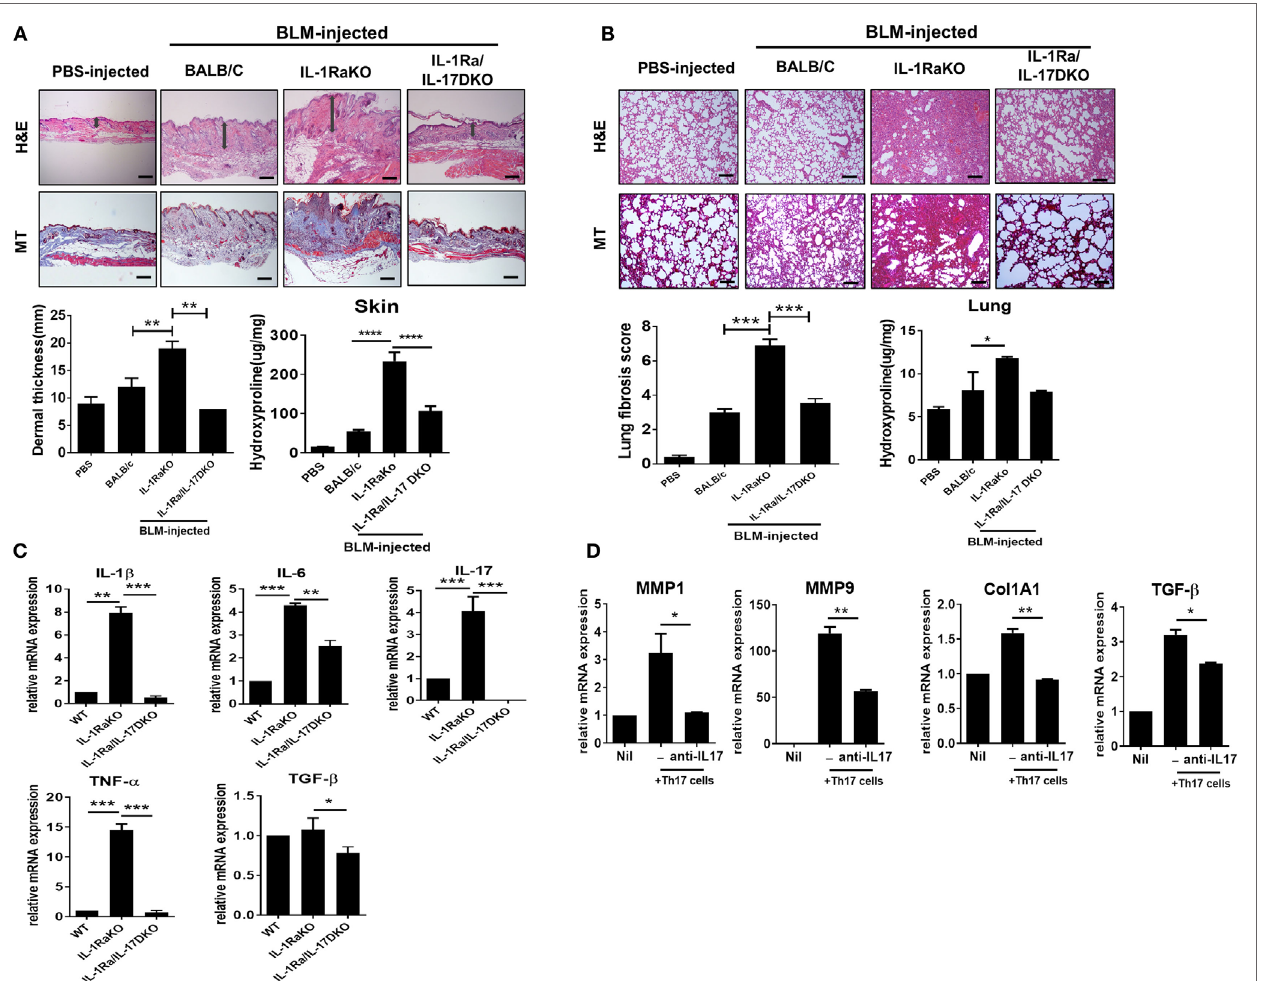
FigUre 2 | Augmented fibrosis in skin and lung tissue from IL-1 receptor antagonist-deficient (IL-1Ra-KO) mice depends on IL-17 activity. Wild-type (WT) BALB/c mice mice received daily injections of phosphate-buffered saline or bleomycin (BLM) for 28 days ( n = 6/group). IL-1Ra-KO and IL-1Ra–IL-17-double KO (DKO) mice received daily injections of BLM for 28 days ( n = 6/group). Then, skin and lung samples were isolated and analyzed. (a,B) Left panel, representative sections stained with hematoxylin and eosin, and Masson’s trichrome (MT) in skin (a) and lung (B) . Original magnification 100 × . Scale bar represents 200 µm. Right panel, quantification of dermal thickness in affected skin and pulmonary fibrosis, showing greater dermal thickness and lung fibrosis in IL-1Ra-KO mice injected with BLM relative to those in WT mice and a significant reduction in IL-1Ra–IL-17-DKO mice relative to those in IL-1Ra-KO mice. Hydroxyproline content in skin and lung tissues from each group of mice. Values are the mean ± SEM of six mice per group. (c) mRNA levels of IL-1 β , IL-6, IL-17, TNF- α , and TGF- β in skin samples from WT, IL-1Ra-KO, and IL-1Ra–IL- 17-DKO mice treated with BLM as determined by real-time quantitative polymerase chain reaction analysis. (D) mRNA levels of MMP1, MMP9, Col1A1, and TGF β in dermal fibroblasts (2 × 10 5 cells) of IL-1Ra-KO mice that were cocultured with in vitro differentiated Th17 cells (2 × 10 6 cells) in the absence or presence of anti-IL-17 antibody (5 µg/ml). The data are expressed as the mean ± SEM for three independent experiments per group. * p < 0.05, ** p < 0.01, *** p <